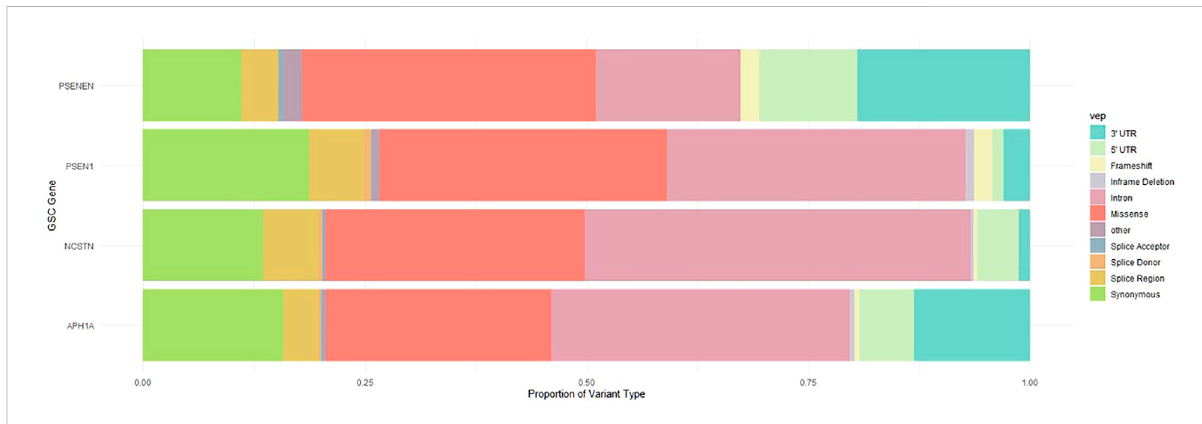
FIGURE 1 Proportion of variant types across these four GSC protein-coding